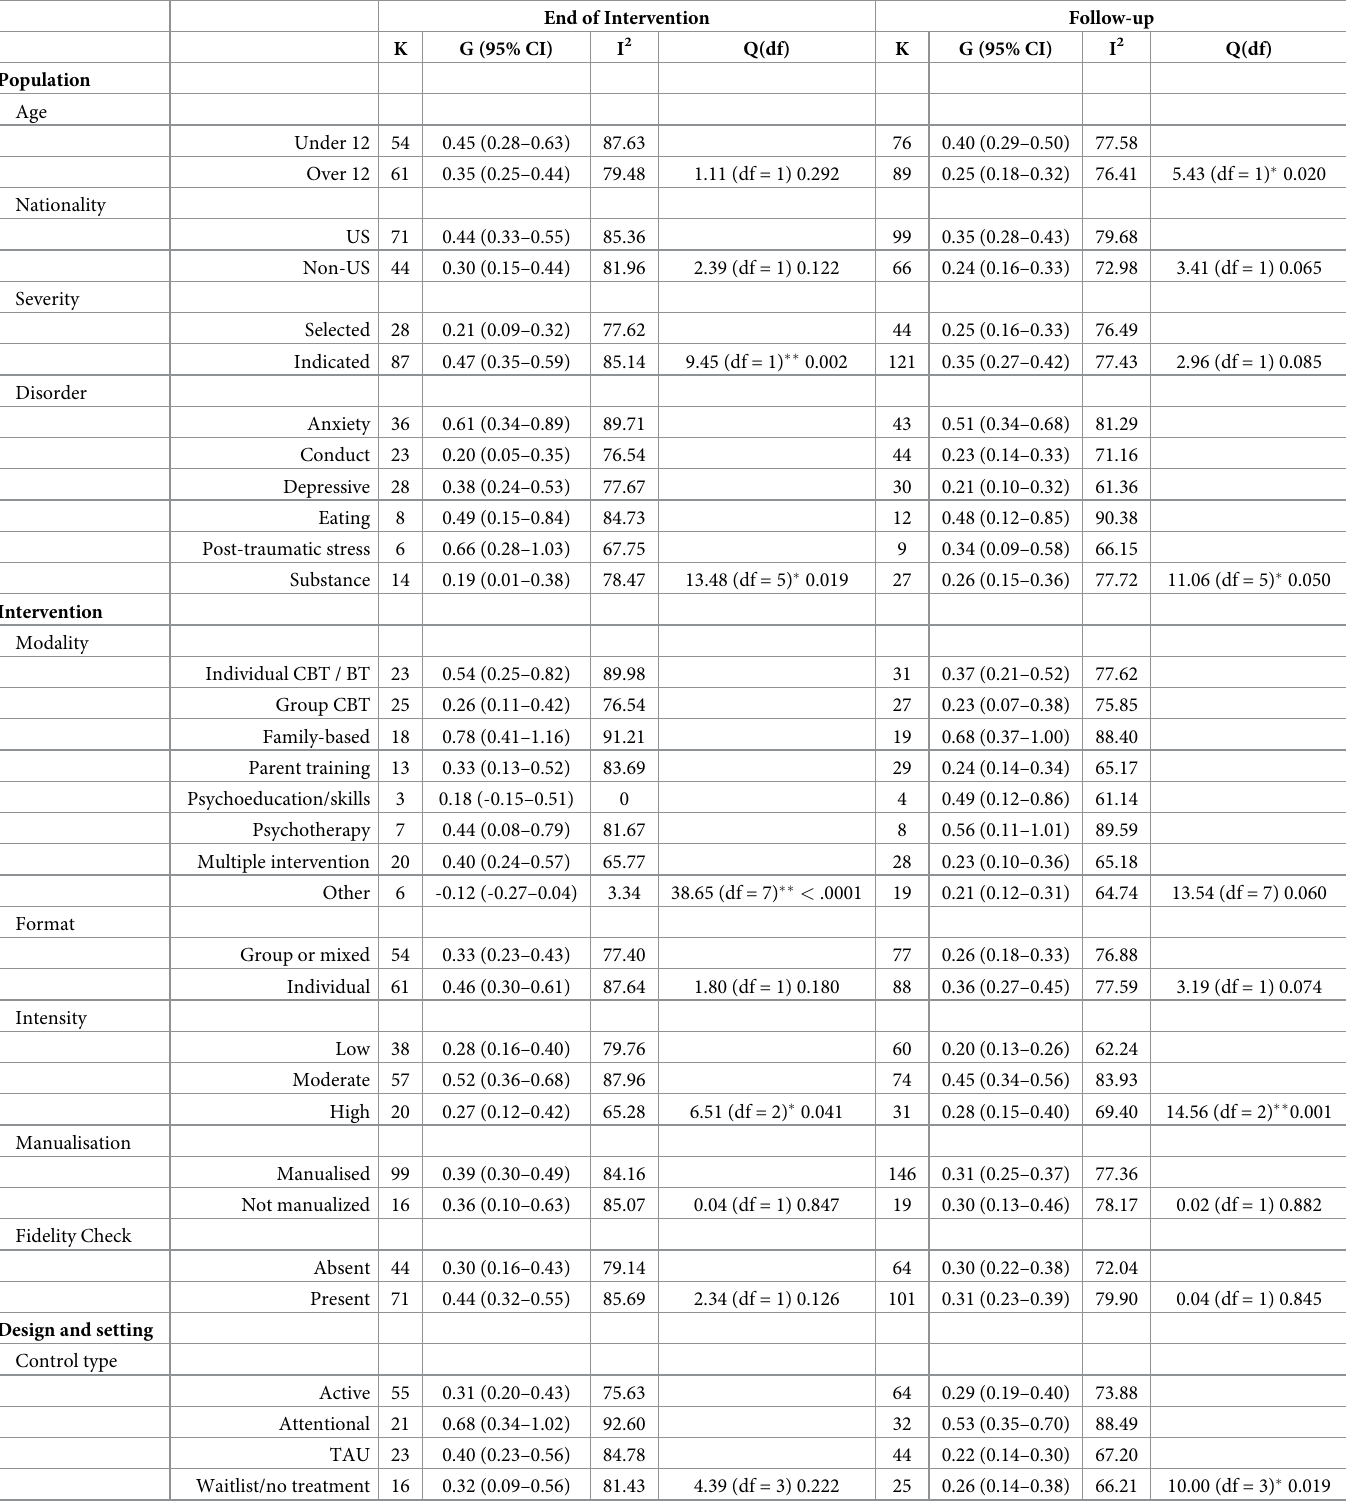
Table 2. Subgroup analysis at end of treatment and follow-up across all